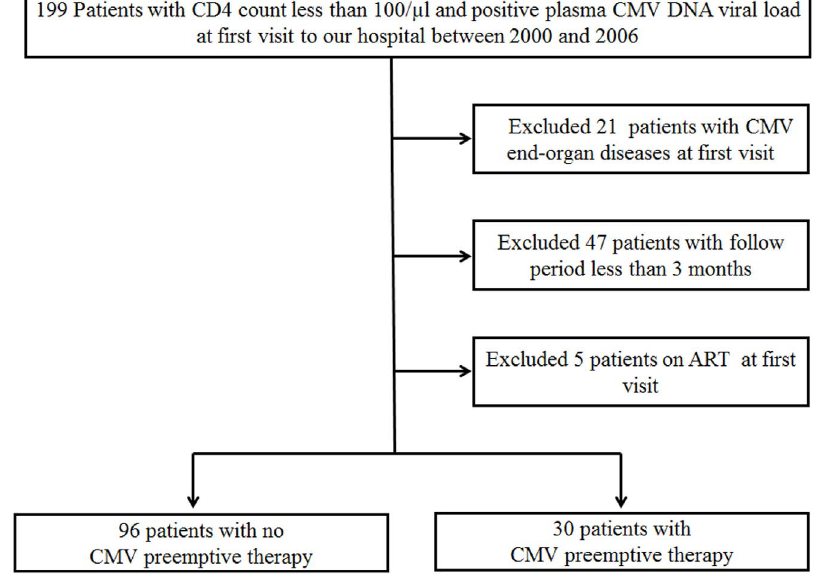
Figure 1. Flow chart of inclusion and exclusion criteria. Of the 199 subjects, 73 were excluded and the remaining 126 were included in the study. The latter group was divided into the preemptive therapy group (n=30) and the non-therapy group (n=96).